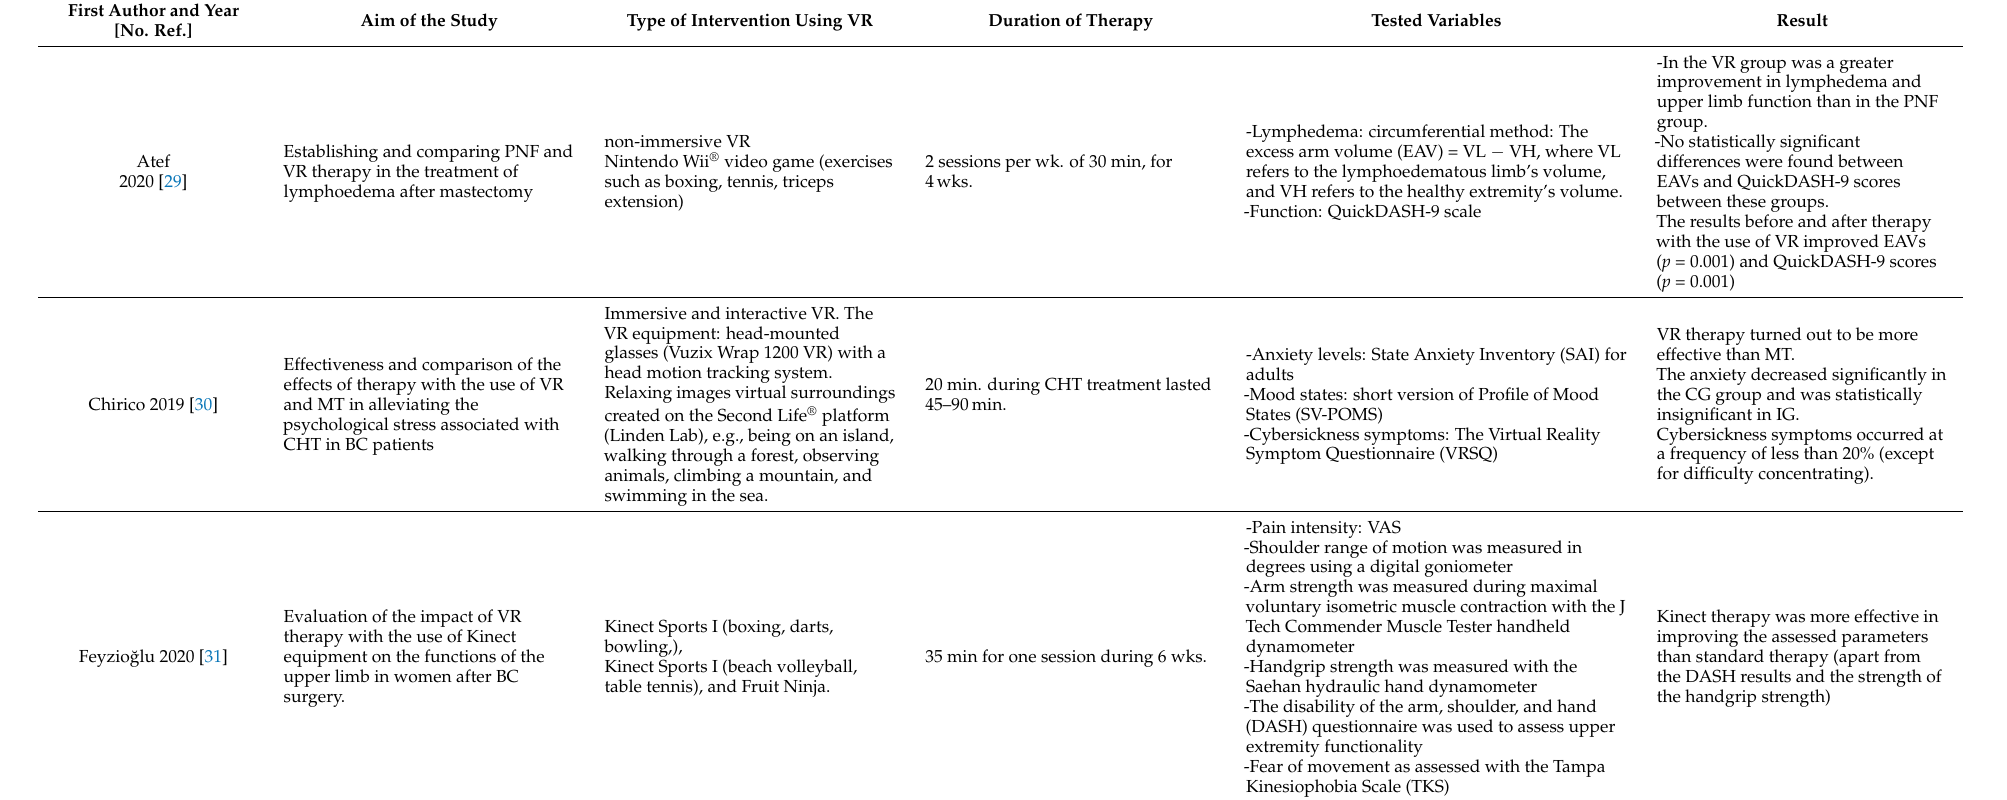
Table 3. Characteristics of aim, intervention, measures, and results of the included